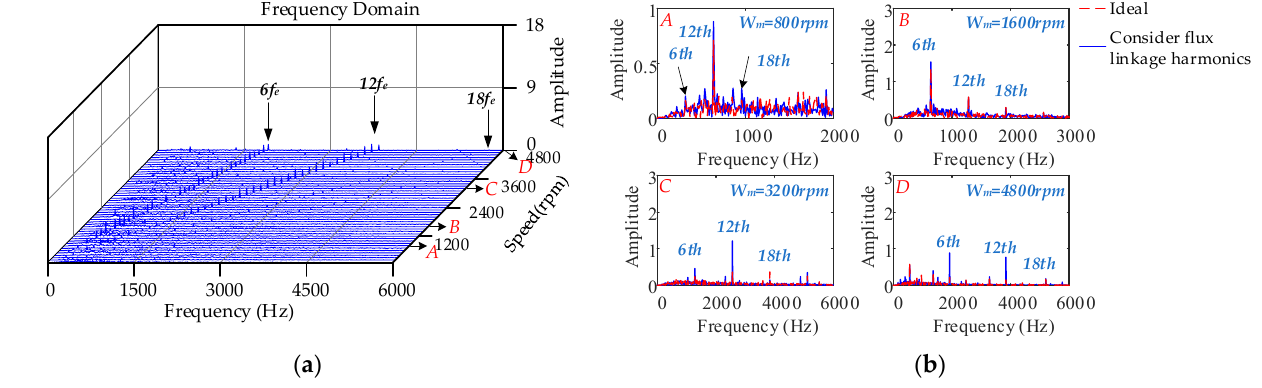
Figure 15. Frequency domain results of electromagnetic torque under different speeds: ( a ) waterfall diagram of electromagnetic torque; ( b ) comparison results of electromagnetic torque.